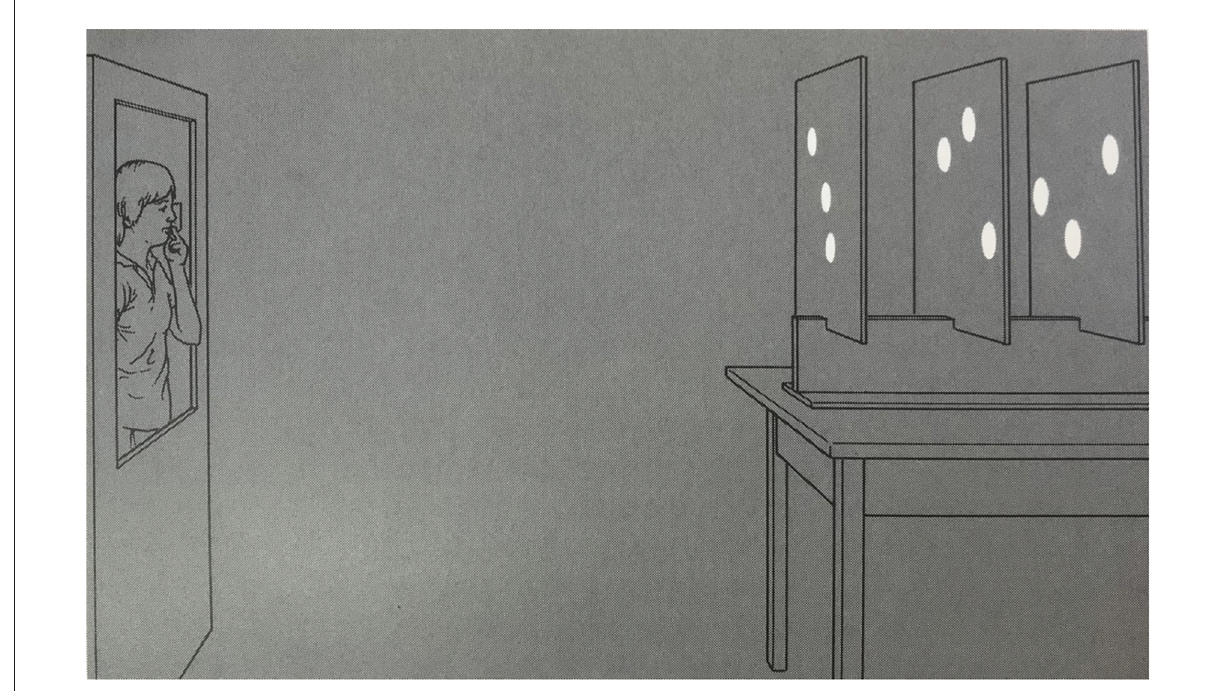
FIGURE6 The apparatus used in Rock’s motion parallax experiment in which a monocular observer moves from side-to-side whilst viewing nine luminous discs in an otherwise dark room (from Rock,